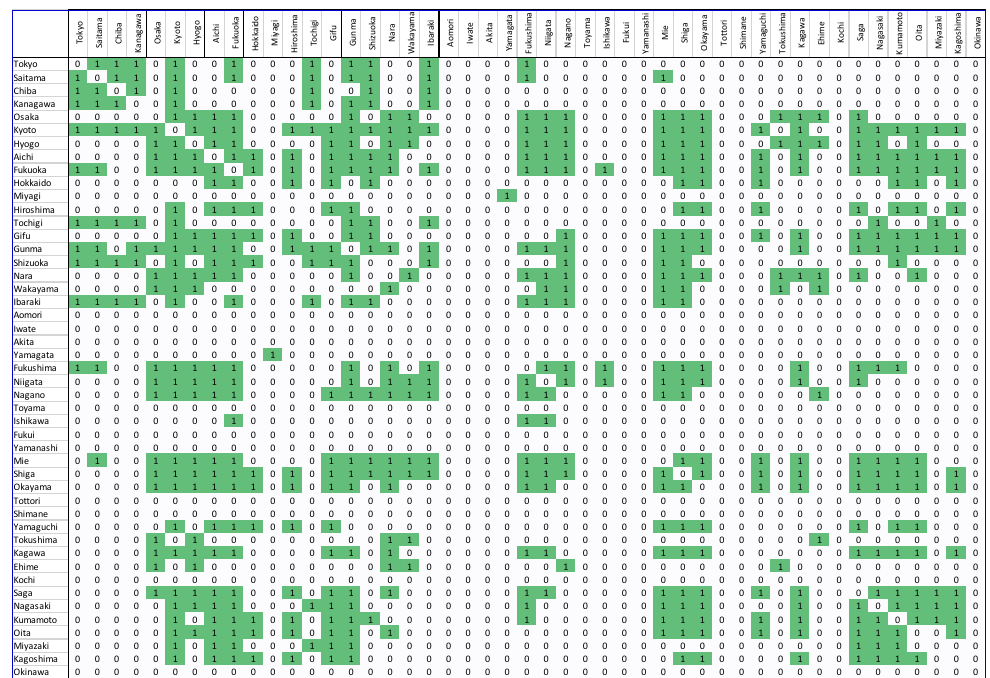
Figure 3. The US COVID ‐ 19 binary matrix. The green color represents a strong correlation between the different regions. All strong correlations are represented by 1.